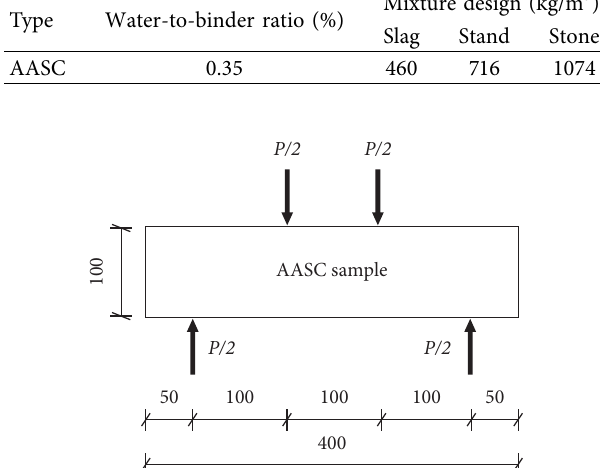
Figure 1: Schematic diagram of the flexural fatigue test.